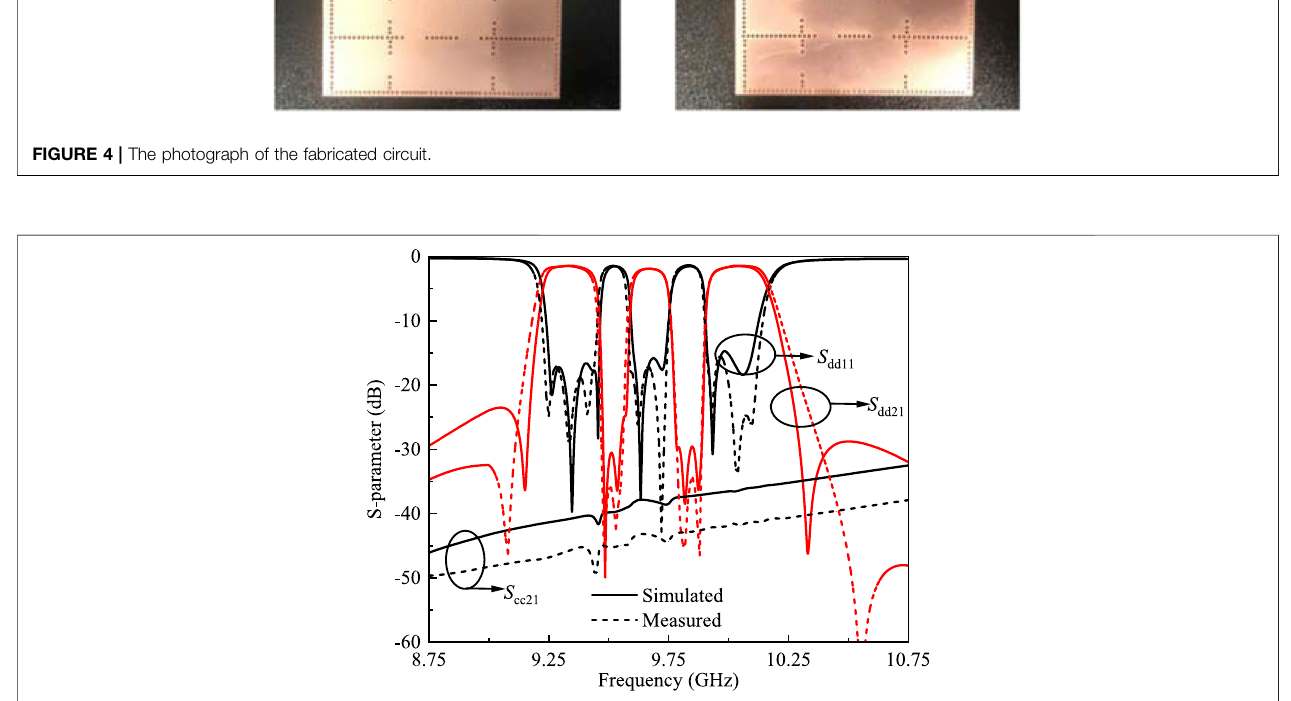
FIGURE 5 | Simulated, and measured S-parameters of proposed balanced tri-band BPF.